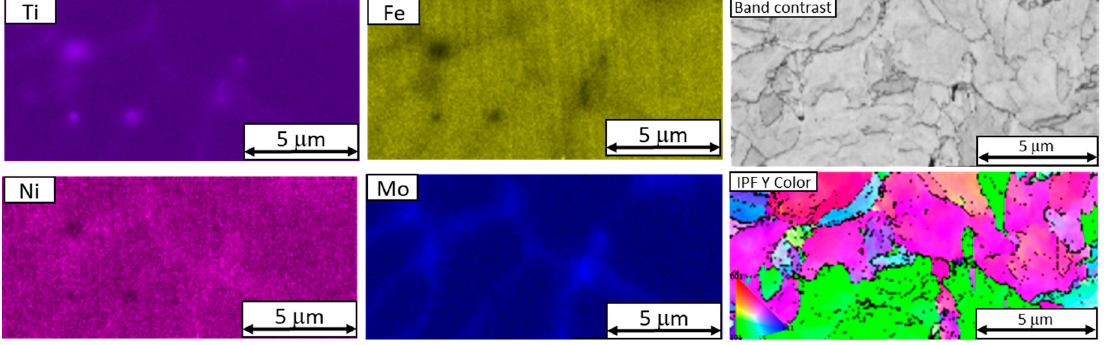
Figure 11. EDS and EBSD maps of a reused powder particle showing chemical segregation along the boundaries of the cellular structure. The band contrast map and the IPF map on the right show the grain structure.